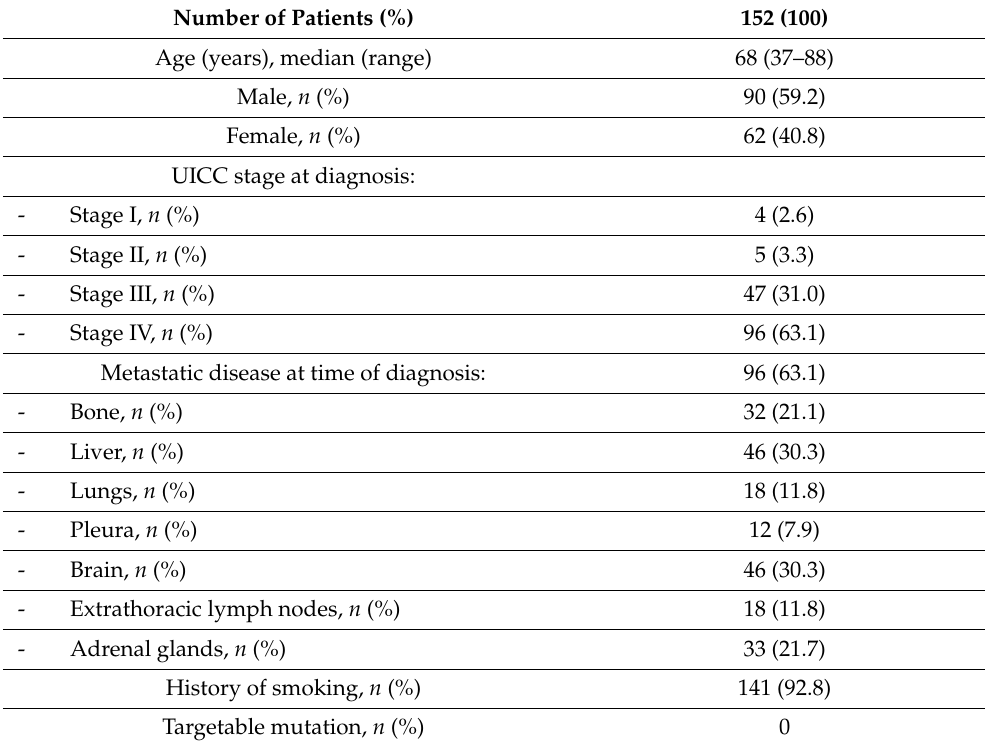
Table 1. Baseline characteristics of the study